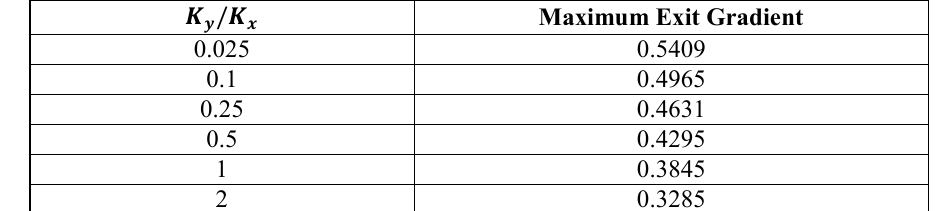
Convergence study for calculating the Depth of the soil